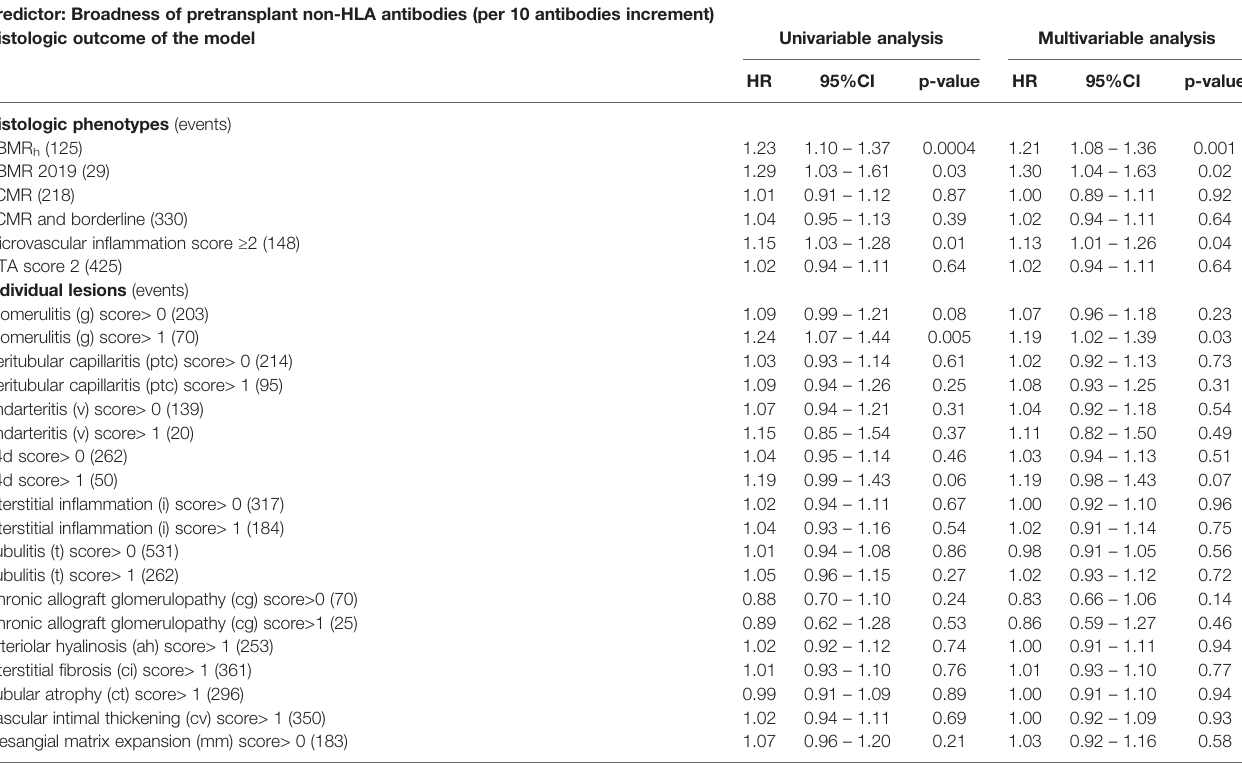
TABLE 3 | Univariable and multivariable Cox proportional hazards analysis for histologic lesions and phenotypes, according to the broadness of pretransplant non-HLA antibodies in the absence of HLA-DSA (N=774). Predictor: Broadness of pretransplant non-HLA antibodies (per 10 antibodies increment) Histologic outcome of the model